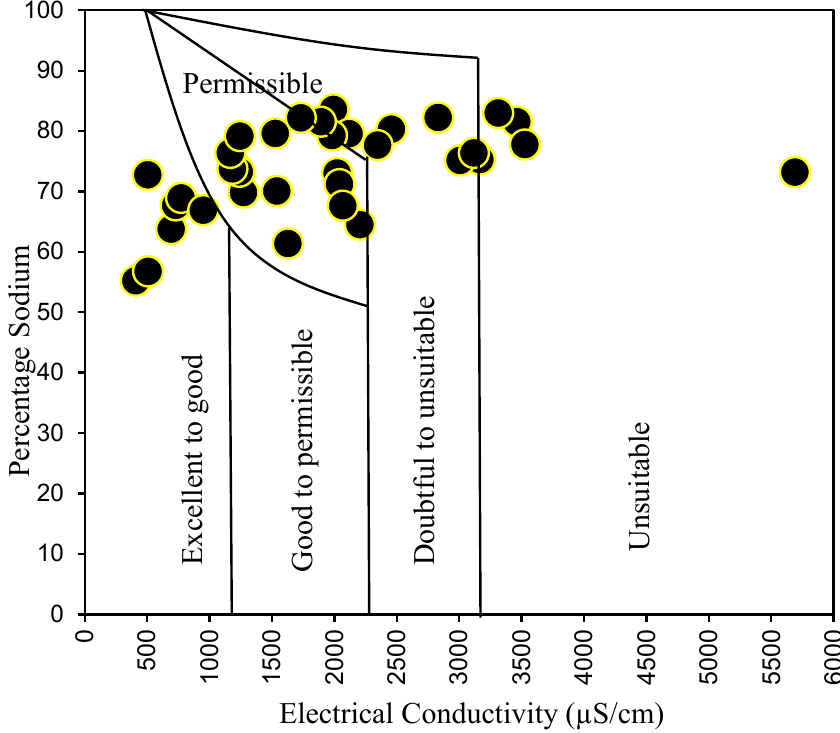
Figure 9. Wilcox diagram explains irrigation water suitability.